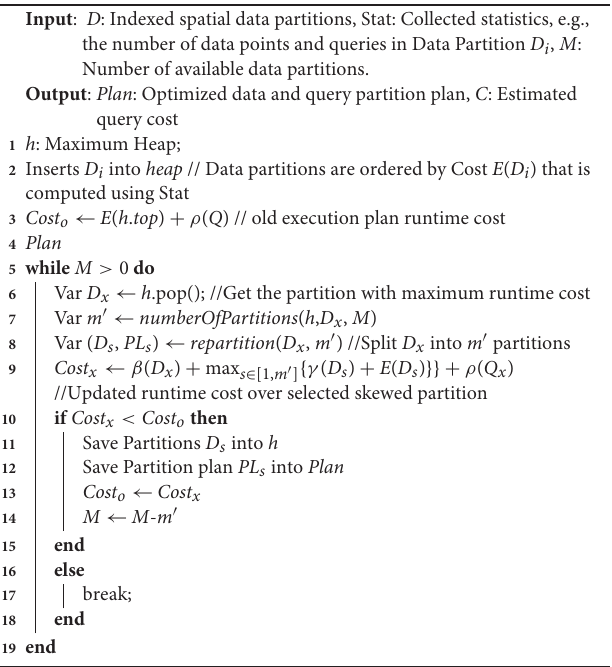
Algorithm 1 : Greedy Partitioning